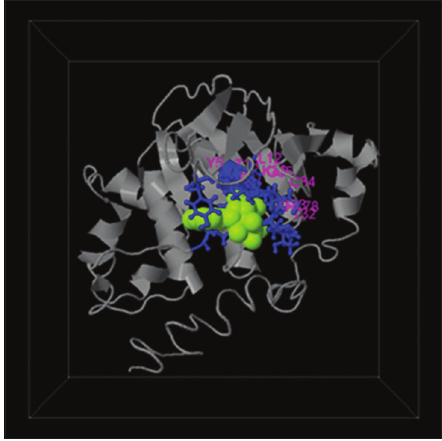
Figure-4: The prediction structure of the highest C-score ligand site (0.8) in Trypanosoma evansi multidrug resistance protein E.